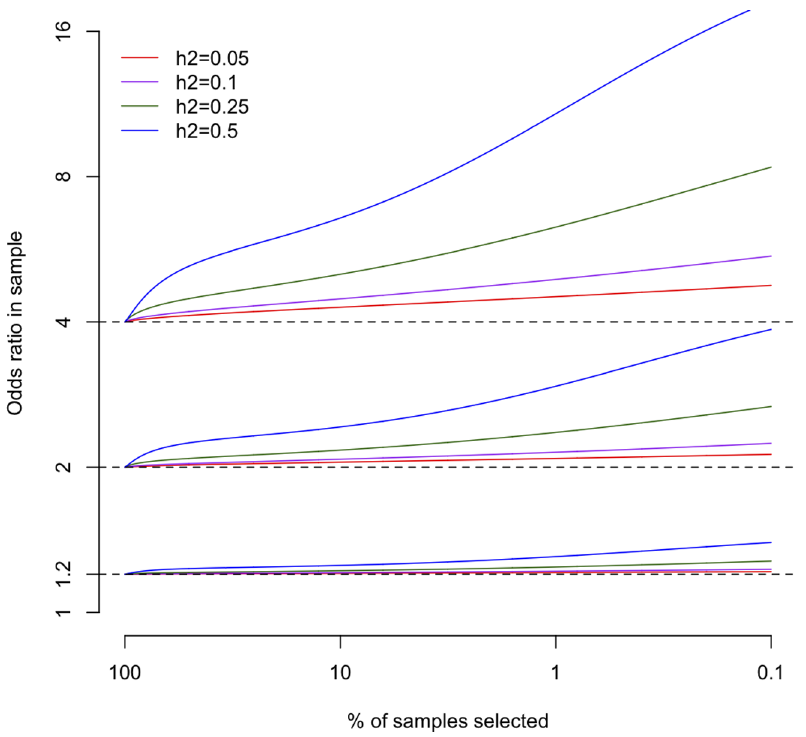
Figure 1. The increase in apparent odds ratio after selecting samples with D y in the top or bottom X %. Coloured lines represent . The odds ratios in unselected individuals were 1.2, 2 and 4, the disease was assumed to different amounts of variance explained by the risk score h 2 p have prevalence K ~ 0 : 01 , and the allele frequency was assumed to be f ~ 0 : 01 .